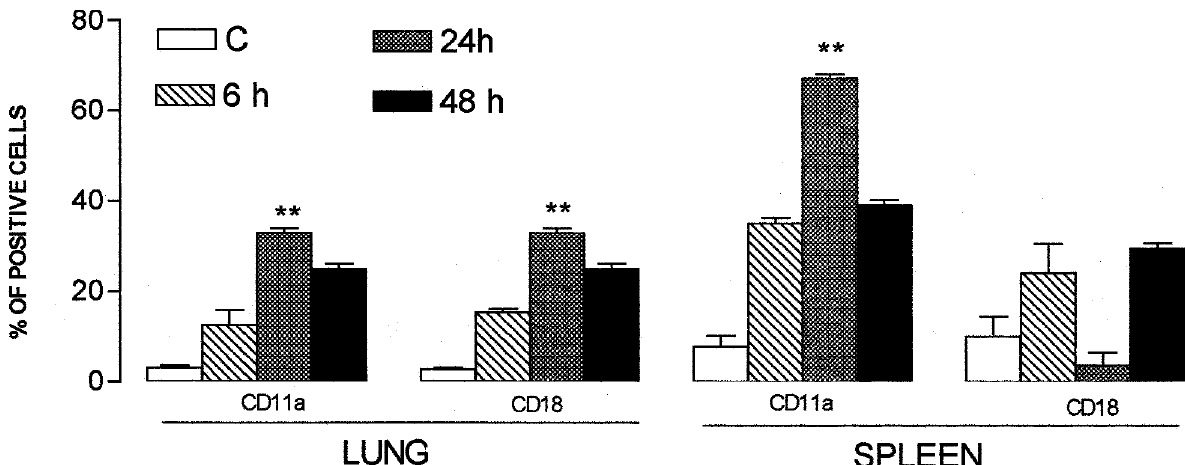
FIG. 4. Time-course profile of the percentage of positive CD11a and CD18 lymphocytes in the lung and spleen obtained from control (C) and peritonitis-induced groups. Each column represents the mean of a pool of two to four organs from at least four to six animals in each experimental group. The vertical bars indicate the SEM. ** p <